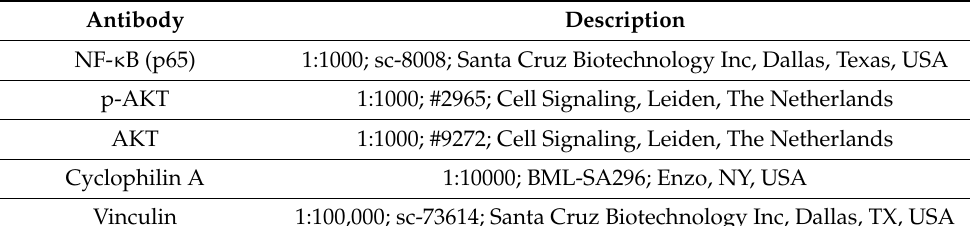
Table 2. Primary antibodies and specific dilutions used in Western Blot